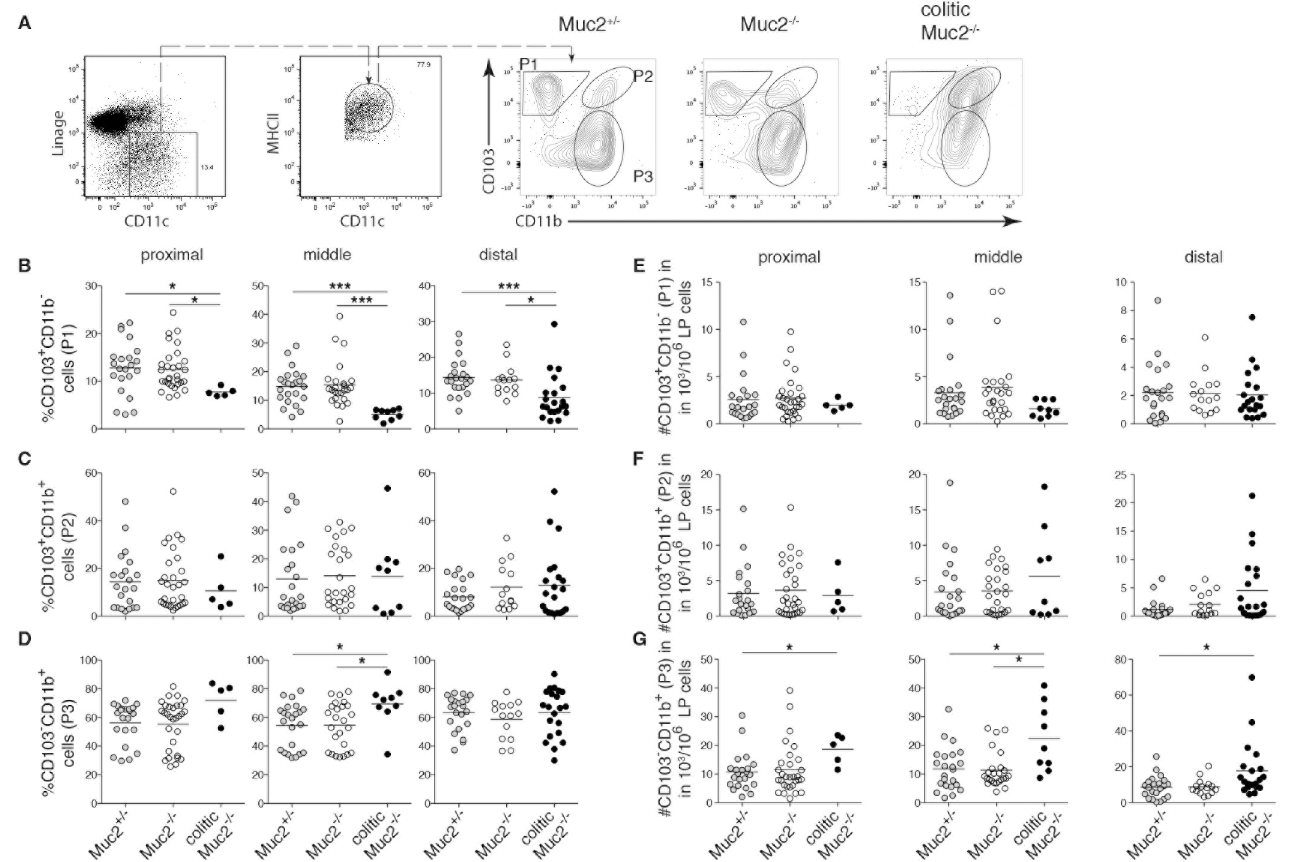
Fig 2. Altered frequency of iMP populations in the colon of Muc2 -/- mice. LP cells from proximal, middle and distal colon of Muc2 +/- controls, Muc2 -/- , and colitic Muc2 -/- mice were analyzed by flow cytometry. (A) A representative dot plot of a Muc2 +/- mouse showing gating of viable NK1.1 - TCR - CD19 - CD11c + MHC-II + cells is depicted in the left two dot plots and further analysis of gated CD11c + MHC-II + cells for expression of CD103 and CD11b for the indicated genotype of mouse is shown to the right. B-D depict the frequency of CD103 + CD11b - "P1" DCs (B), CD103 + CD11b + "P2" DCs (C), and CD103 - CD11b + "P3" iMPs (D) among viable LP cells in the indicated gates. E-G show the absolute number of viable CD103 + CD11b - "P1" DCs (E), CD103 + CD11b + “ P2 ” DCs (F) and CD103 - CD11b + “ P3 ” iMPs (G). Each symbol represents an individual mouse. For B-G results from the proximal (left column), middle (center column) and distal (right column) colon are shown. The mean of each group is indicated by the horizontal line. Segregating Muc2 -/- mice into colitic and non-colitic is performed according to neutrophil influx in the respective colon segment. Data are from 12 independent experiments that analyzed 14 – 22 mice per group. Statistical significance between groups was assessed using the Kruskal-Wallis test followed by Dunn ’ s multiple comparison test.